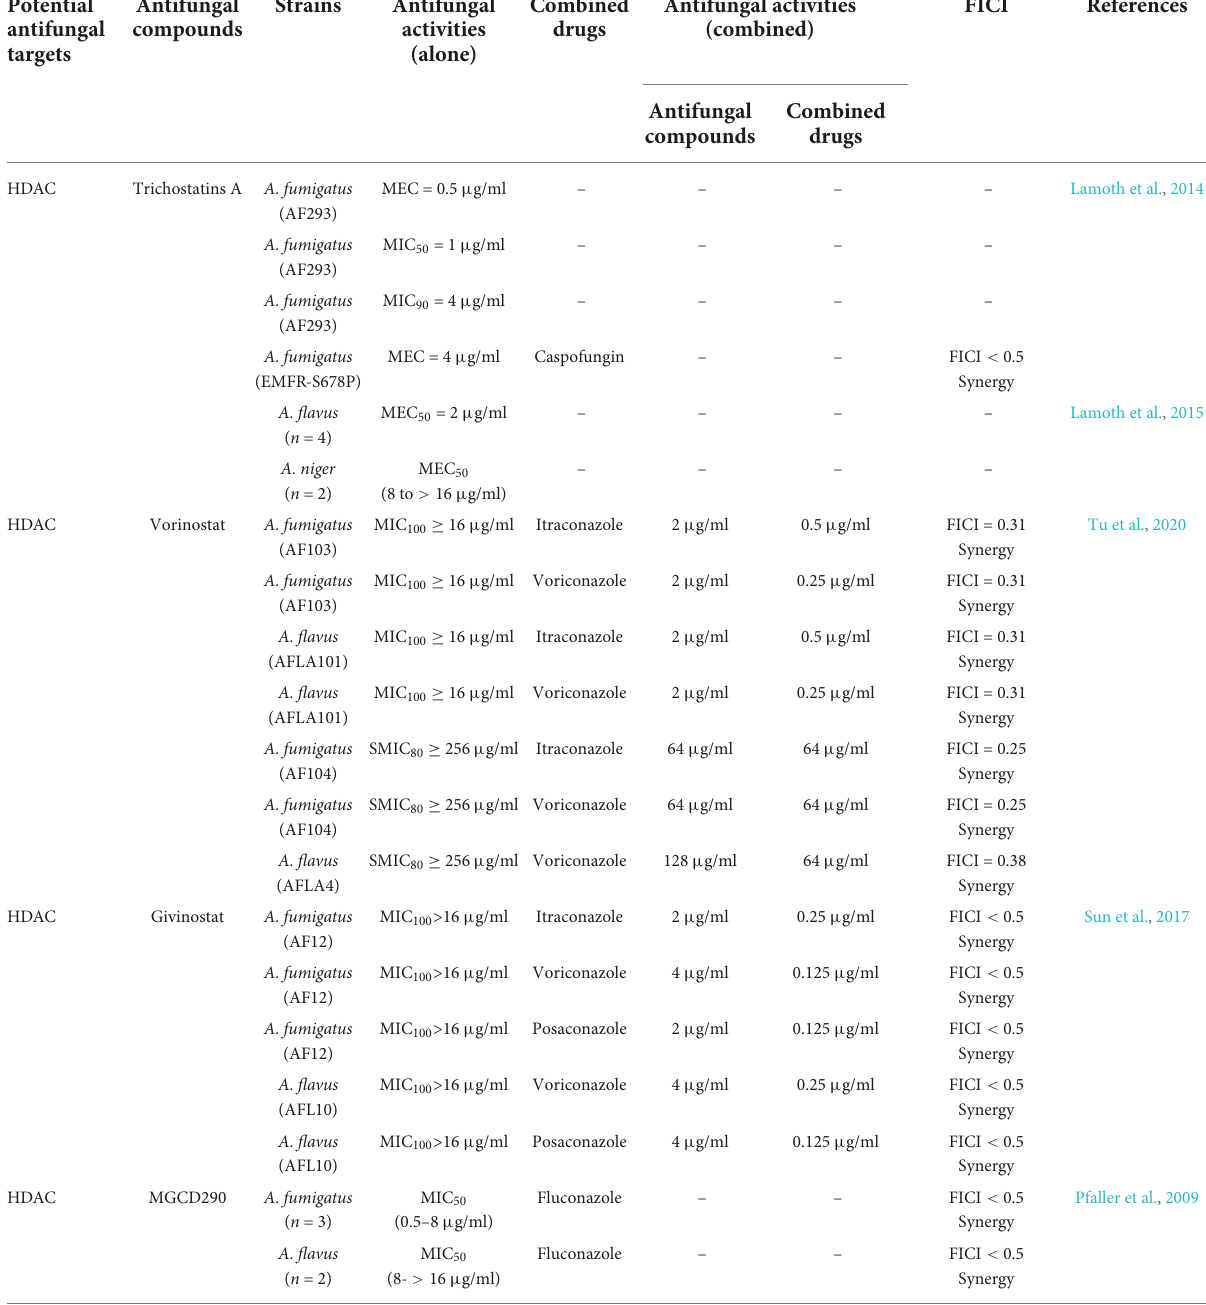
TABLE 2 Antifungal activities of compounds against Aspergillus spp. based on